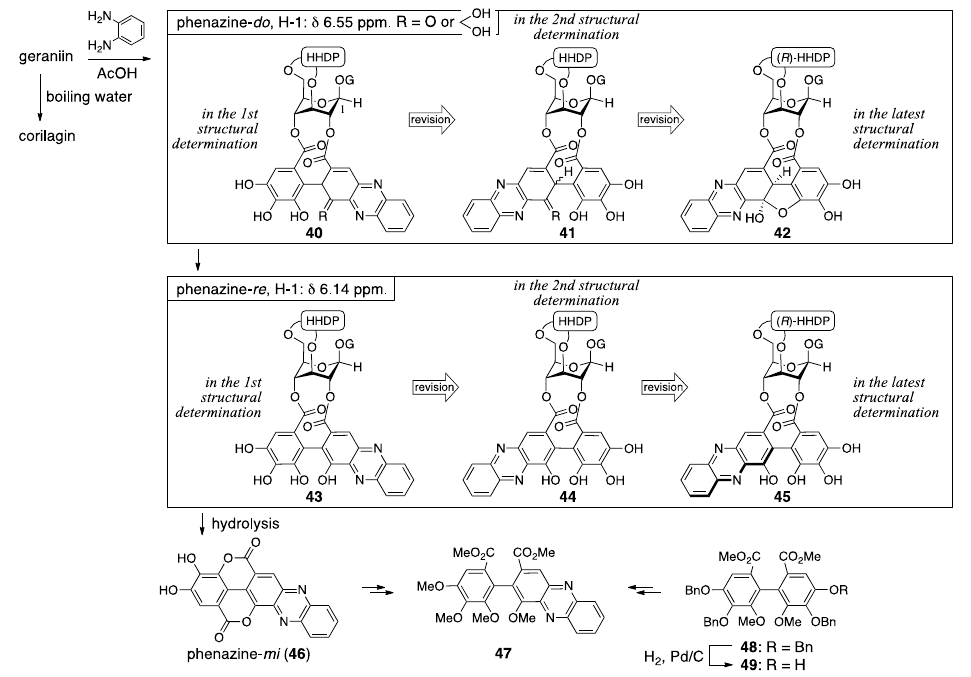
Figure 20. The hydrolysis and derivatization of geraniin.